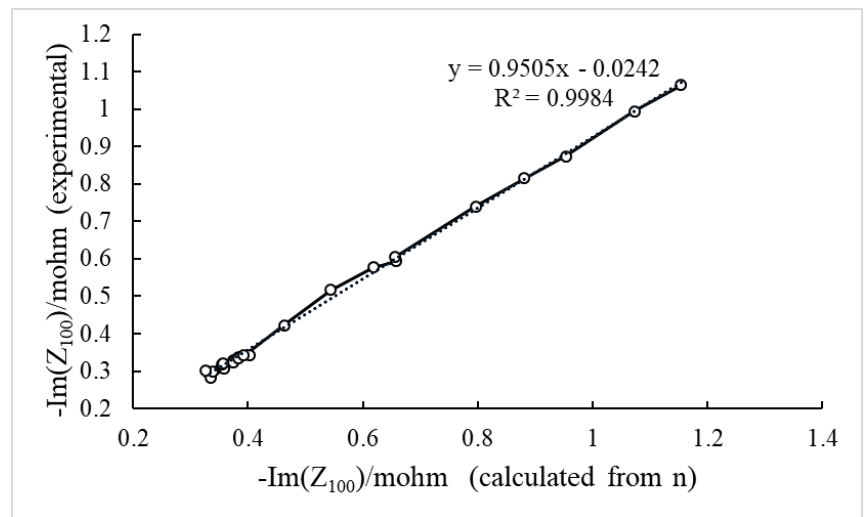
Figure 9. The correlation between the reactance at 100 Hz and n .